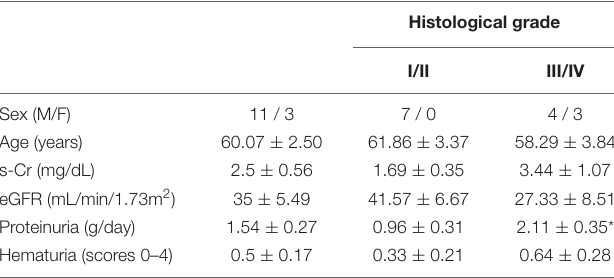
TABLE 1 | Clinical findings at the time of renal biopsy in Diabetic Nephropathy ( n =